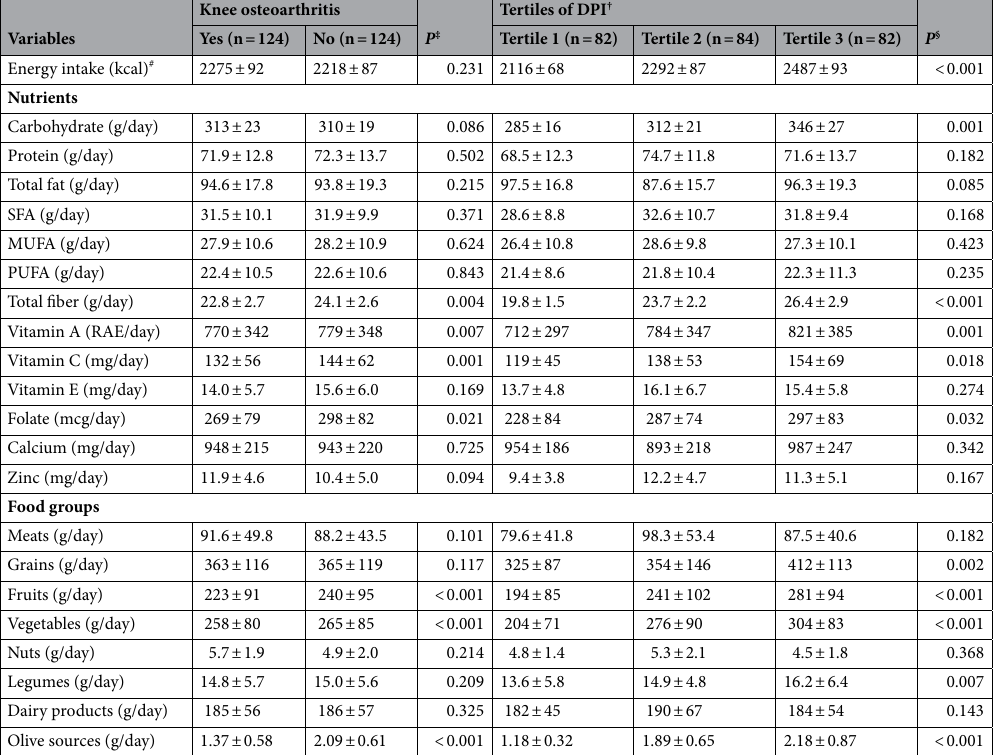
Table 2. Dietary intakes of patients with knee osteoarthritis, controls and all the participants across tertiles of dietary phytochemical index (DPI). Data are expressed as mean ± standard deviation. Min and Max of DPI in the participants were 12.2 and 62.1, respectively. DPI dietary phytochemical index, RAE retinol activity equivalents, SFA saturated fatty acids, MUFA monounsaturated fatty acid, PUFA polyunsaturated fatty acid. † Tertile cut-points of DPI are as follows: first tertile, < 26.80; second tertile, 26.80 to 33.15; third tertile, > 33.15. ‡ Obtained from independent samples t -test. § Obtained from ANCOVA. # Energy intake is adjusted for sex and age; all other values are adjusted for age, sex and total energy